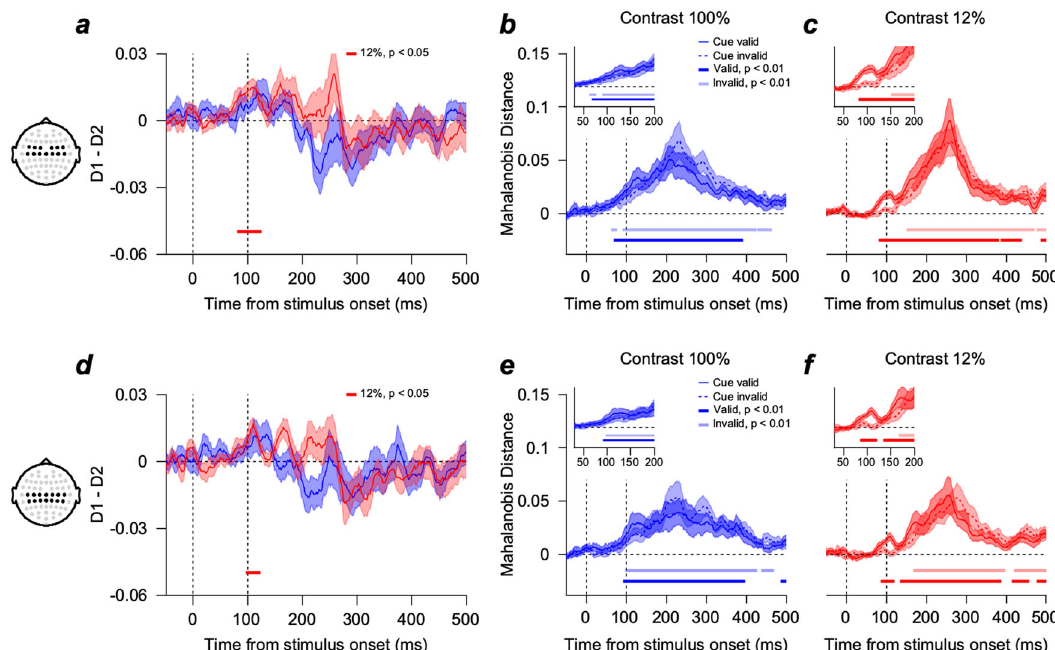
Fig. 4 Multivariate EEG activity pattern dissimilarity (Mahalanobis distance) between upper and lower tracking trials from frontal-central channels (FC1, FC2, FC3, FC4, FC5, FC6, Cz, C1, C2, C3, C4, C5, and C6) and central-parietal channels (Cz, C1, C2, C3, C4, C5, C6, CPz, CP1, CP2, CP3, CP4, CP5, and CP6). The fi gure format for a – c and d – f is the same as in Fig. 2. a Difference between EEG pattern dissimilarities of valid and invalid conditions from the frontal-central channels. Neural direction discrimination was signi fi cantly better in the cue-valid than in the cue-invalid condition (two-sided cluster-based permutation test, n = 14, cluster-de fi ning threshold p < 0 : 05, corrected signi fi cance level p < 0 : 05, 50,000 permutations). b , c EEG pattern dissimilarity from the frontal-central channels when the target contrast was 100% (blue) and when the target contrast was 12% (red). The dark-colored line (valid) and light-colored line (invalid) at the bottom of each plot show the time points where Mahalanobis distance was signi fi cantly different from zero (two-sided cluster-based permutation test, n = 14, cluster-de fi ning threshold p < 0 : 01, corrected signi fi cance level p < 0 : 01, 50,000 permutations). d Difference between EEG pattern dissimilarities of valid and invalid conditions from the central-parietal channels. The fi gure format is the same as in Fig. 4a. e , f EEG pattern dissimilarity from the central-parietal channels. The format is the same as in Fig. 4b, c. The color-shaded areas denote the standard